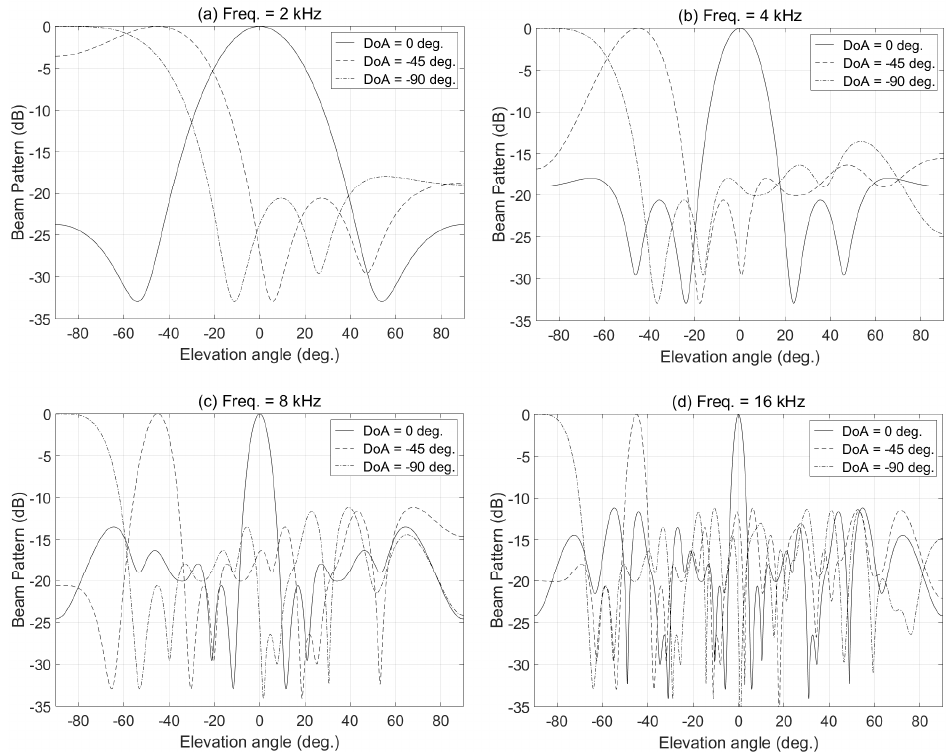
Figure 3. Beam patterns of the uniformly-weighted planar array at the frequencies of: ( a ) 2 kHz; ( b ) 4 kHz; ( c ) 8 kHz; and ( d ) 16 kHz. All of the beam patterns are calculated at the azimuth angle of 0°. The direction of arrival (DoA) refers to the elevation angle with the azimuth angle of 0°.